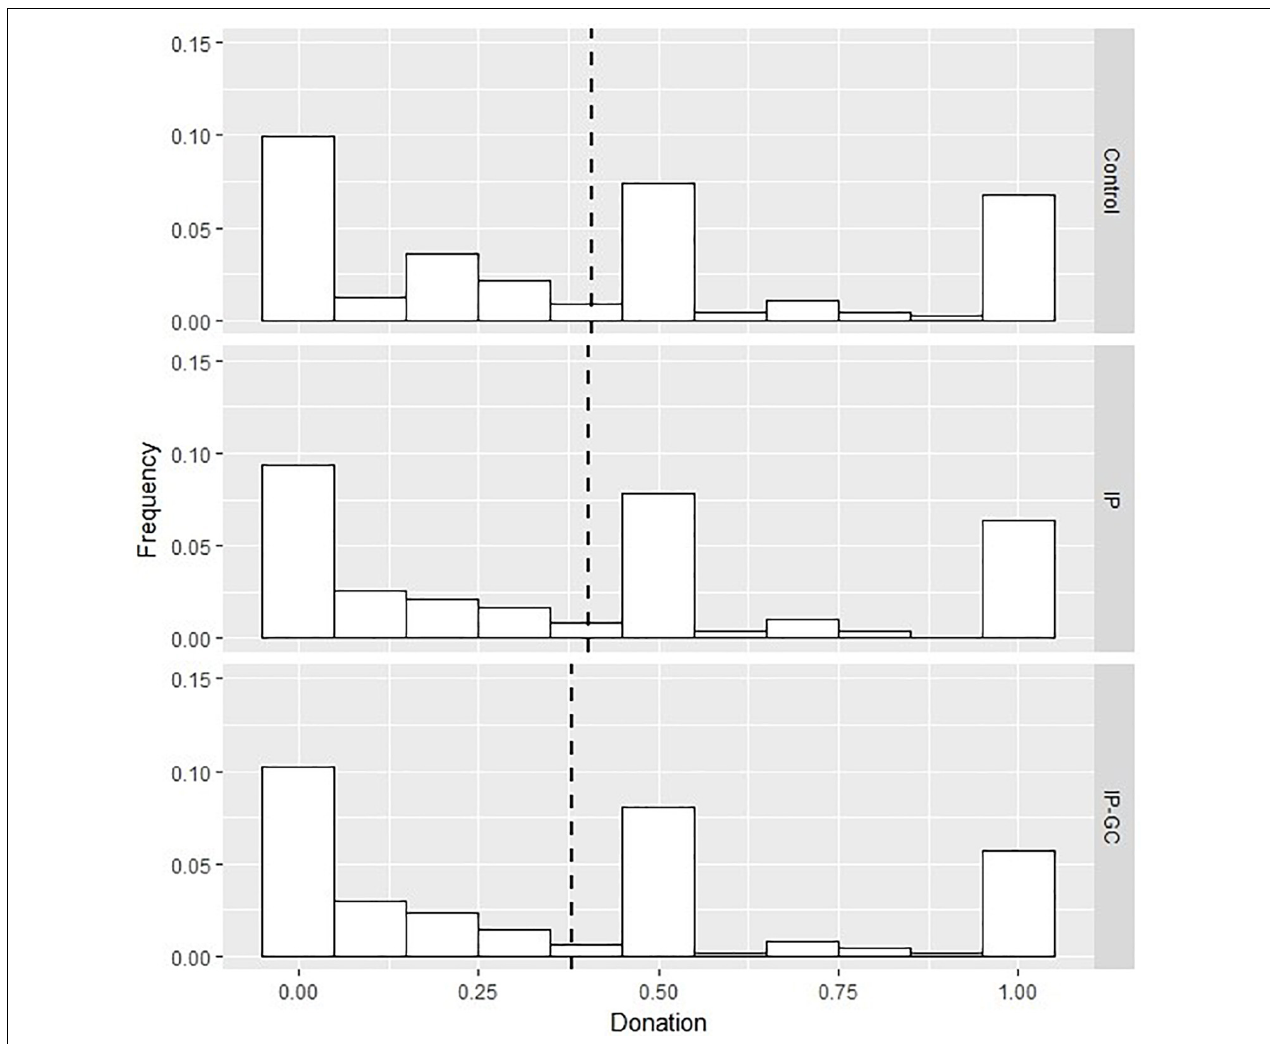
FIGURE 3 | Distribution of donation per experimental condition, Study 2. IP, identity priming; IP – GC, identity priming and goal commitment. Dashed lines represent mean values.